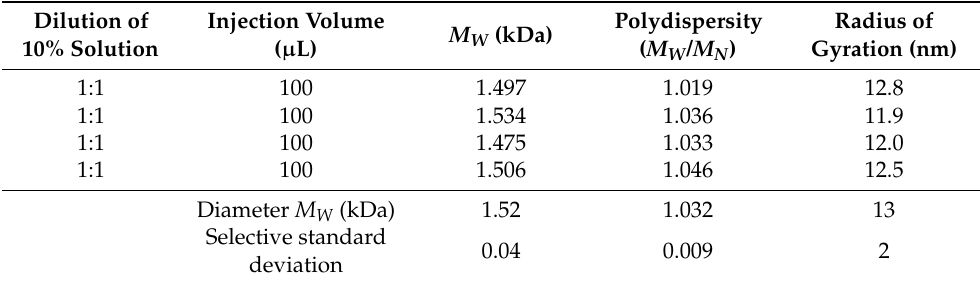
Table 2. The results of GPC. The polydispersity is close to 1, which means that the particles in solution have similar sizes.